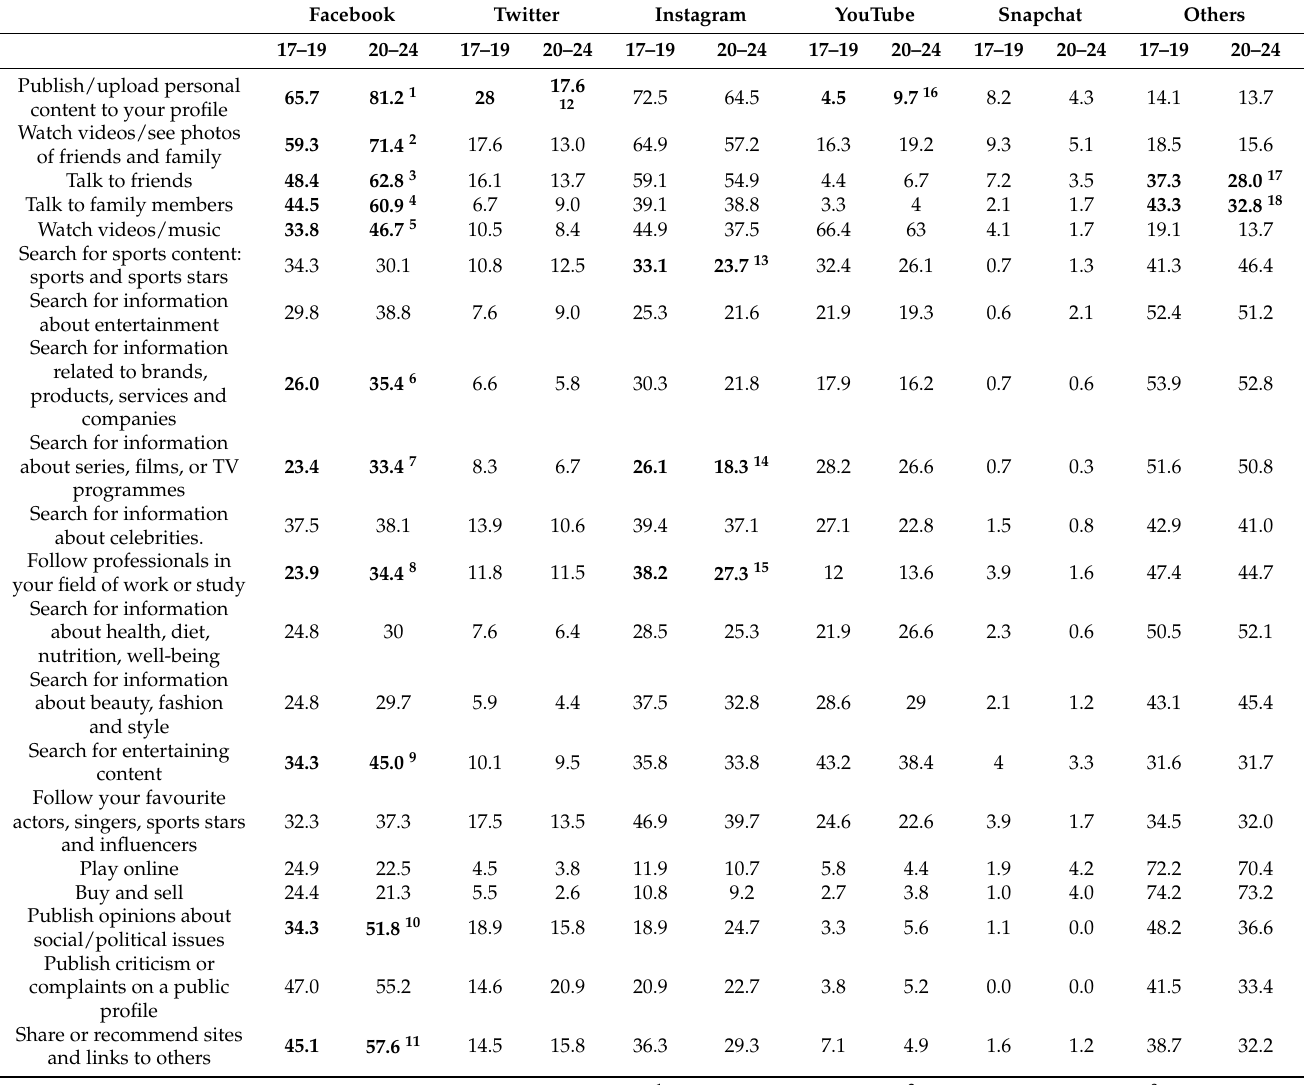
Table 4. Use of social networks by platform among young people aged 17 to 24 in the Autonomous Region of Madrid, according to age group. In